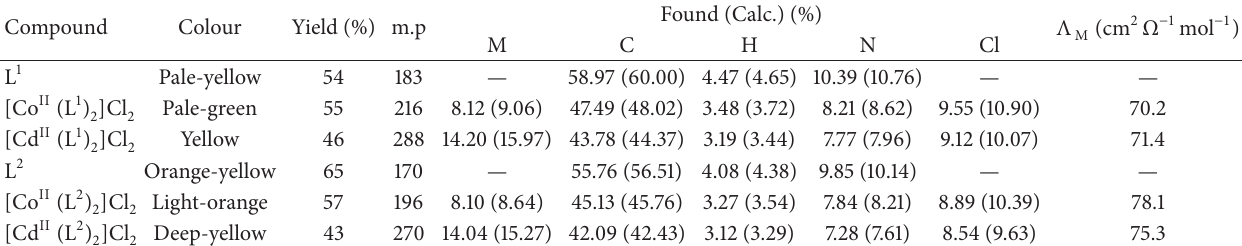
Table 1: Colours, yields, elemental analyses and molar conductance values.